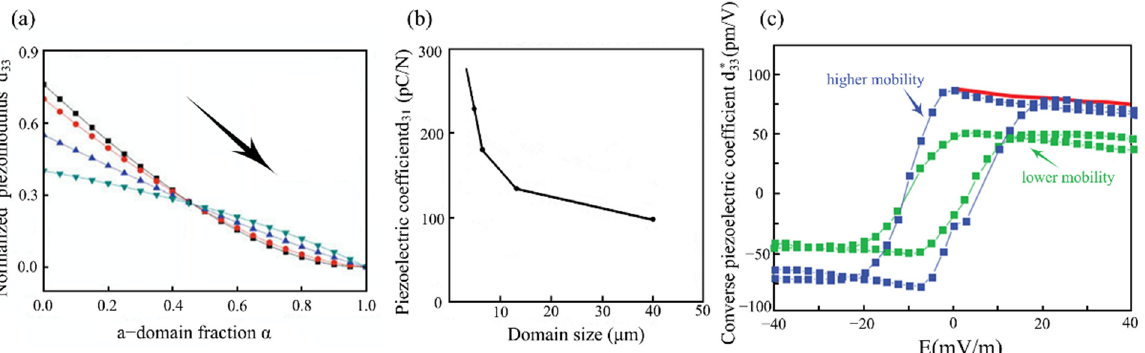
Figure 1. ( a ) Normalized piezomodulus as a function of a-domain fraction α : as α increases, d 33 shows a decreasing trend.